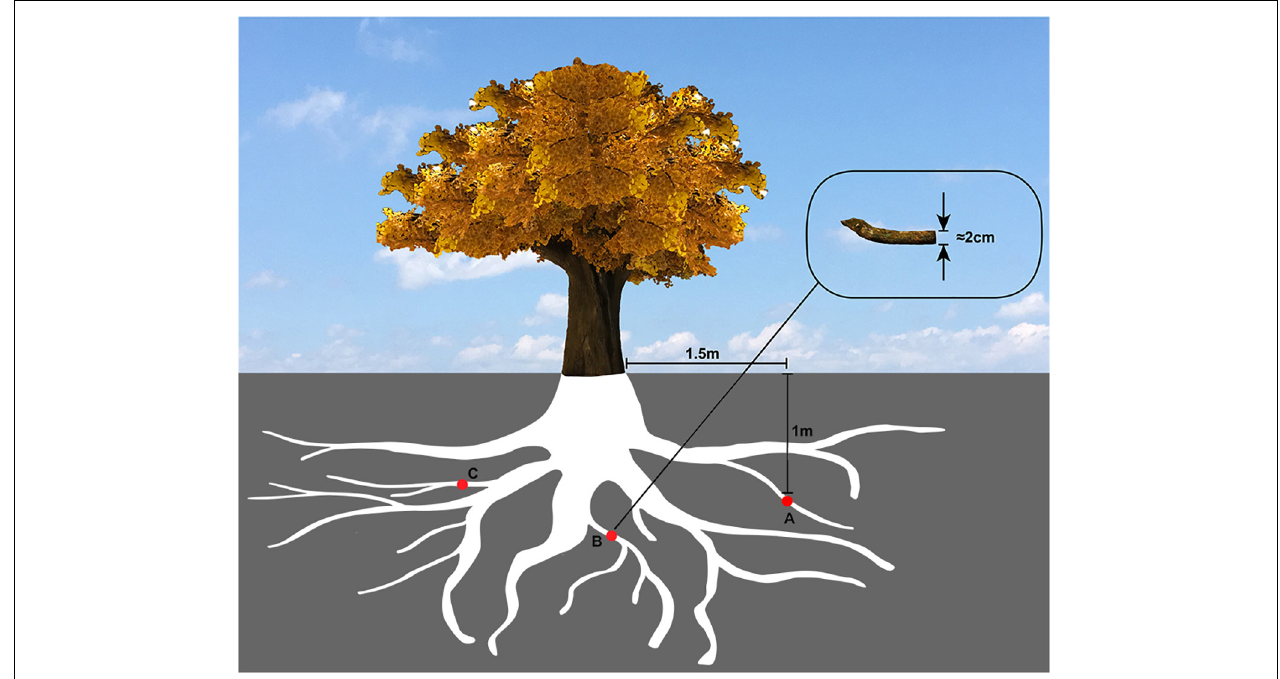
FIGURE 1 | The sampling diagram of Ginkgo roots. The red circles (A,B,C) represented the Ginkgo roots’ sampling sites, which were evenly located around the tree, 1.5 m horizontally away from the trunk and 1 m deep